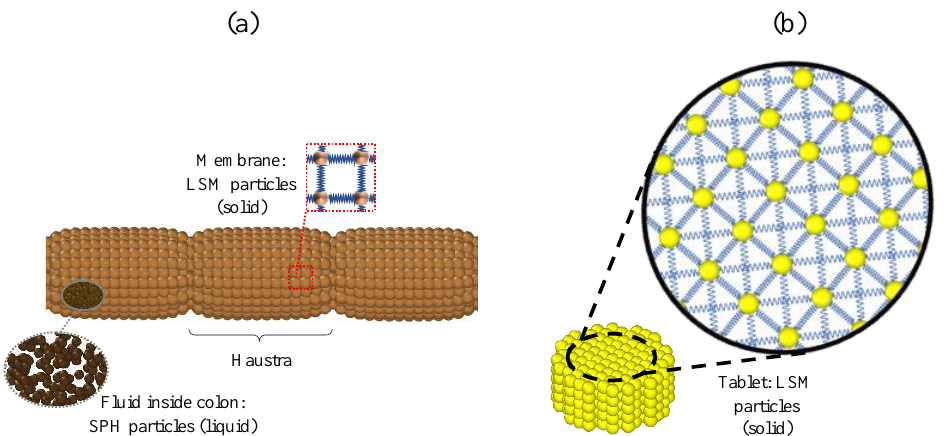
Figure 1. ( a ) Section of the flexible membrane, showing the colon’s haustra and the intestinal fluid inside the colon. The membrane is built of particles which are connected by a network of springs to achieve a flexible behaviour. ( b ) 3D sketch of the tablet. The particles representing the tablet are connected by linear and diagonal springs to obtain a solid behaviour.